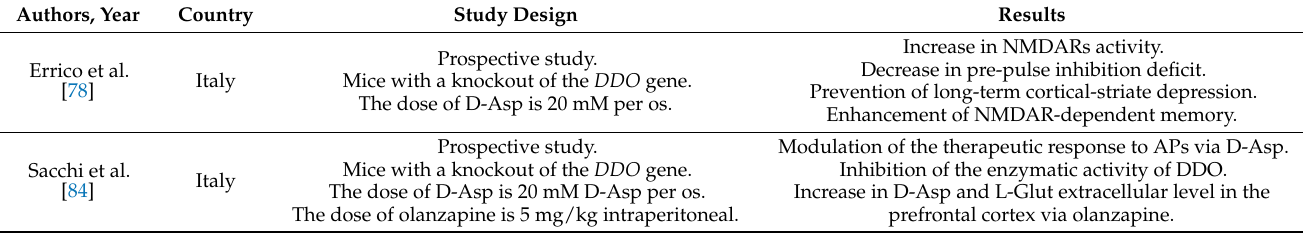
Table 2. Preclinical studies of D-aspartate as a new therapeutic strategy for treatment-resistant